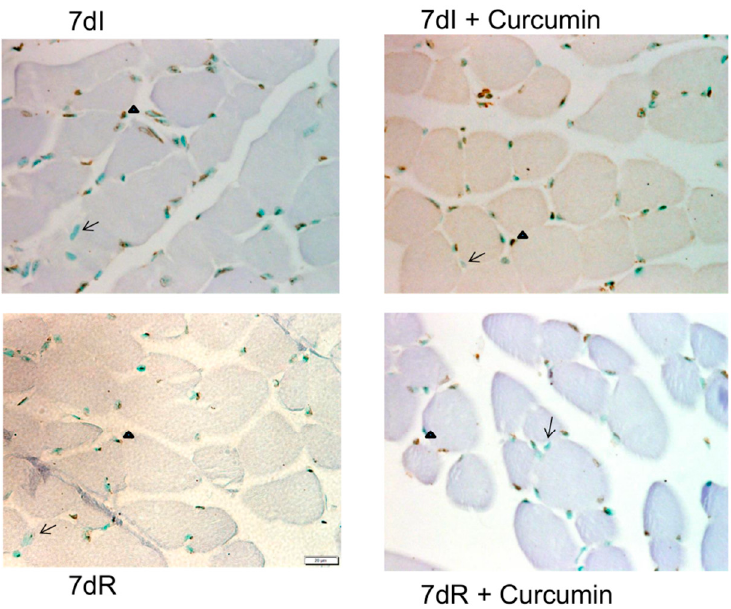
Figure 3. Representative examples of positively-stained nuclei (arrowheads) and negatively-stained nuclei (arrows) for the TUNEL assay in the gastrocnemius muscles of all the study groups of mice. Definition of abbreviations: I, immobilization; R, recovery.